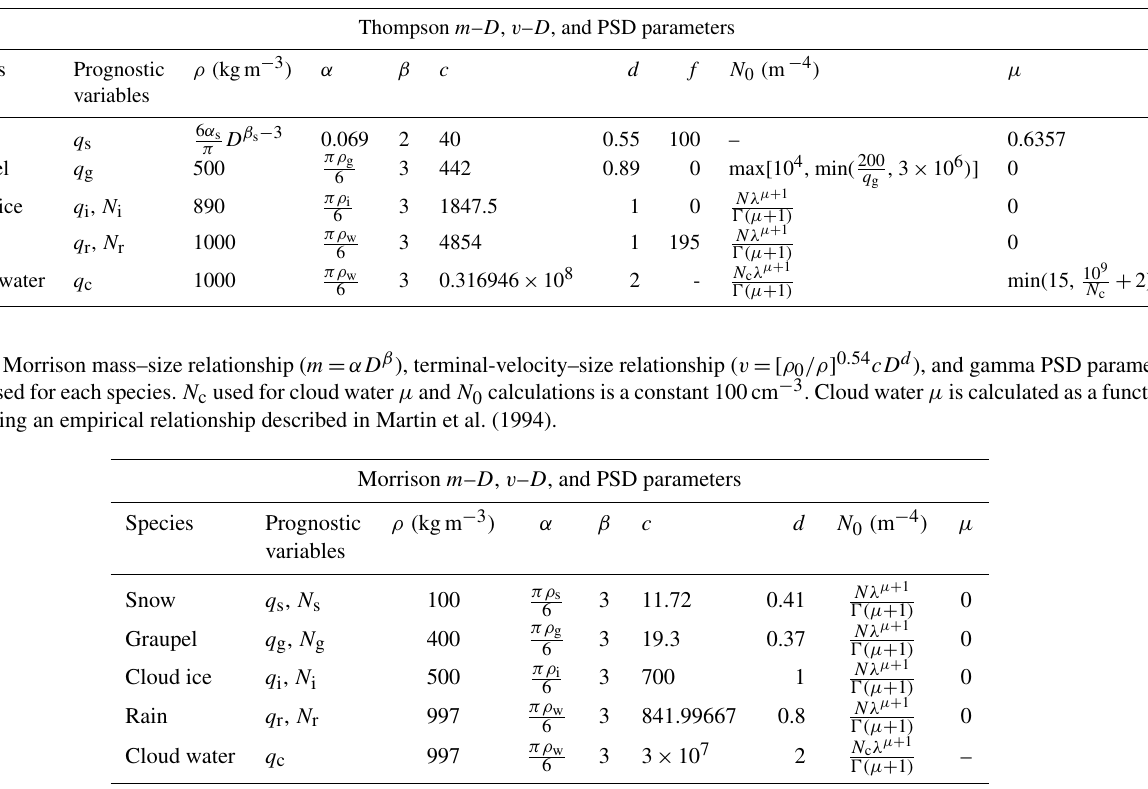
Table 1. Thompson mass–size relationship ( m = αD β ), terminal-velocity–size relationship ( v =[ ρ 0 /ρ ] 1 / 2 cD d exp [− f D ] ), and gamma PSD parameter values used for each species. N c used for cloud water µ and N 0 calculations is a constant 100cm − 3 . N 0 equations for double-moment species are determined by prognostic N and q . The bimodal gamma distribution used for the Thompson snow PSD may be found in Thompson et al. (2008), Eq. (1). The f parameter in the terminal-velocity–size relationship follows Ferrier (1994).